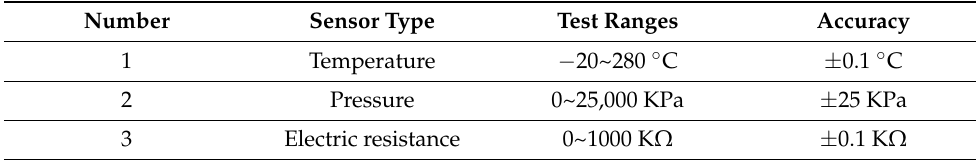
Figure 10. ( a ) Electric resistance, ( b ) temperature measurement points distribution, and gas inlet configurations in the DSSWS. Table 1. Summary of the specific parameters of the various sensors.